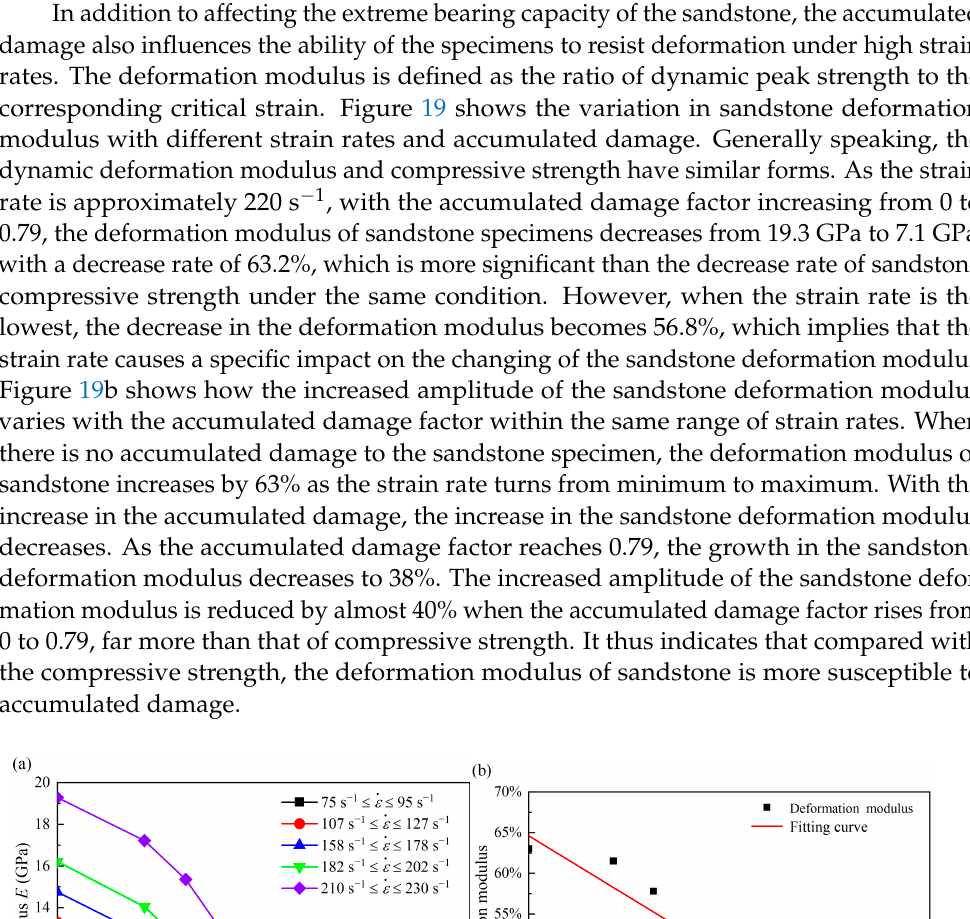
Figure 20. Dynamic increase factor (DIF) of the deformation modulus.